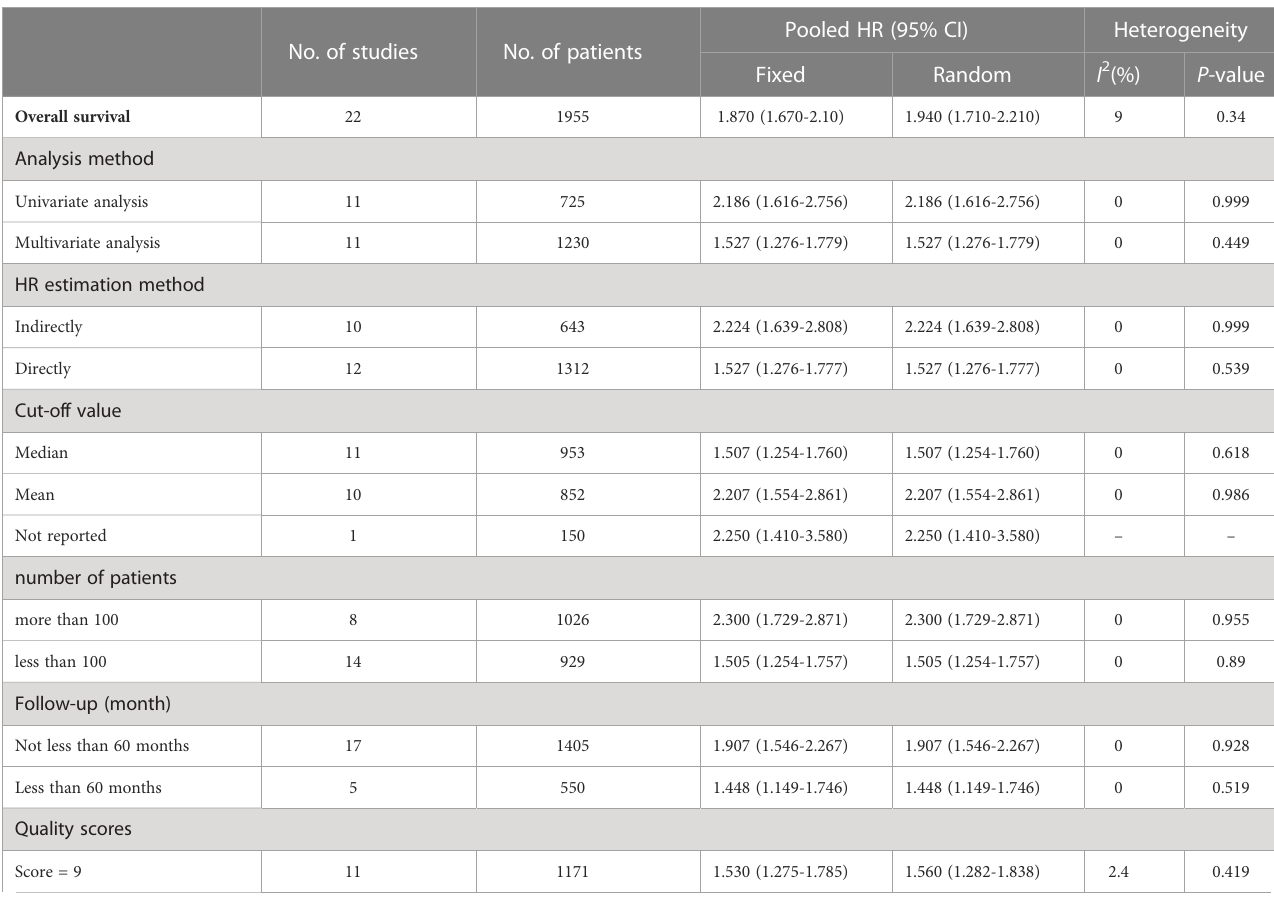
Pooled HR (95% CI) Heterogeneity Fixed Random I 2 (%) P- value